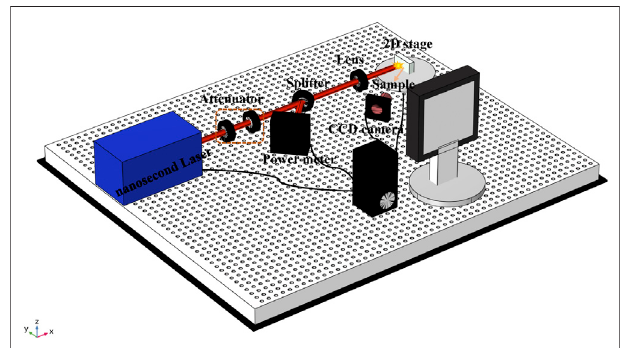
FIGURE 3 | Diagram of the experimental setup of nanosecond laser damage to the